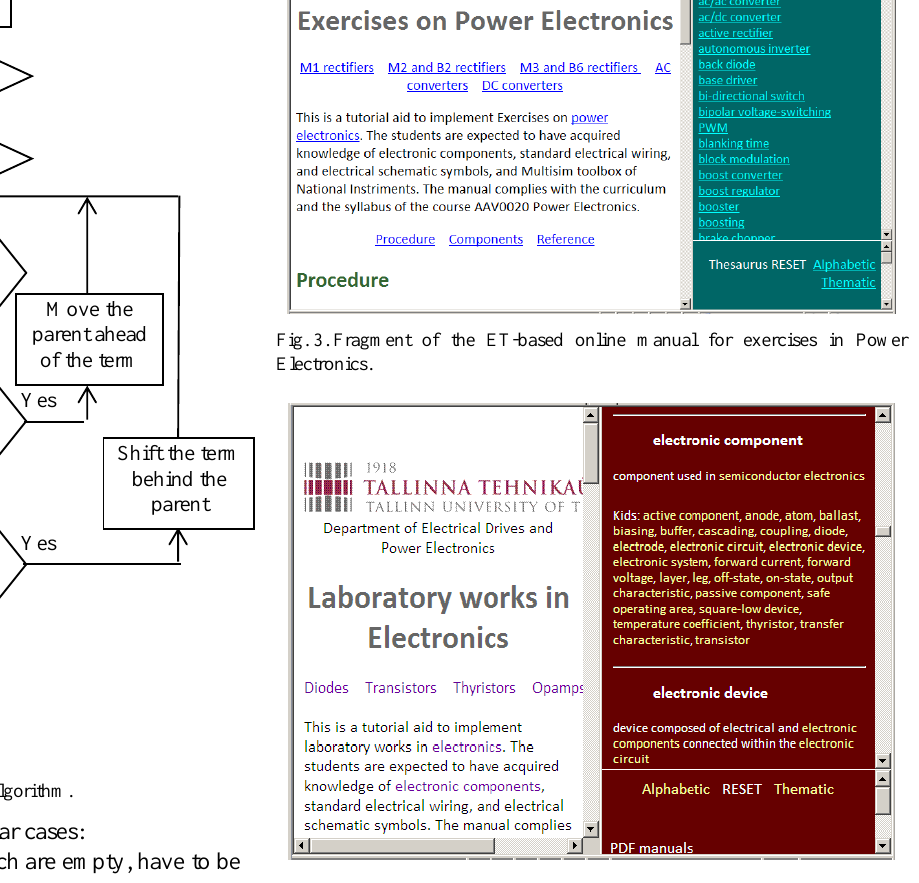
Fig. 4. Fragment of the ET-based online manual for labs in